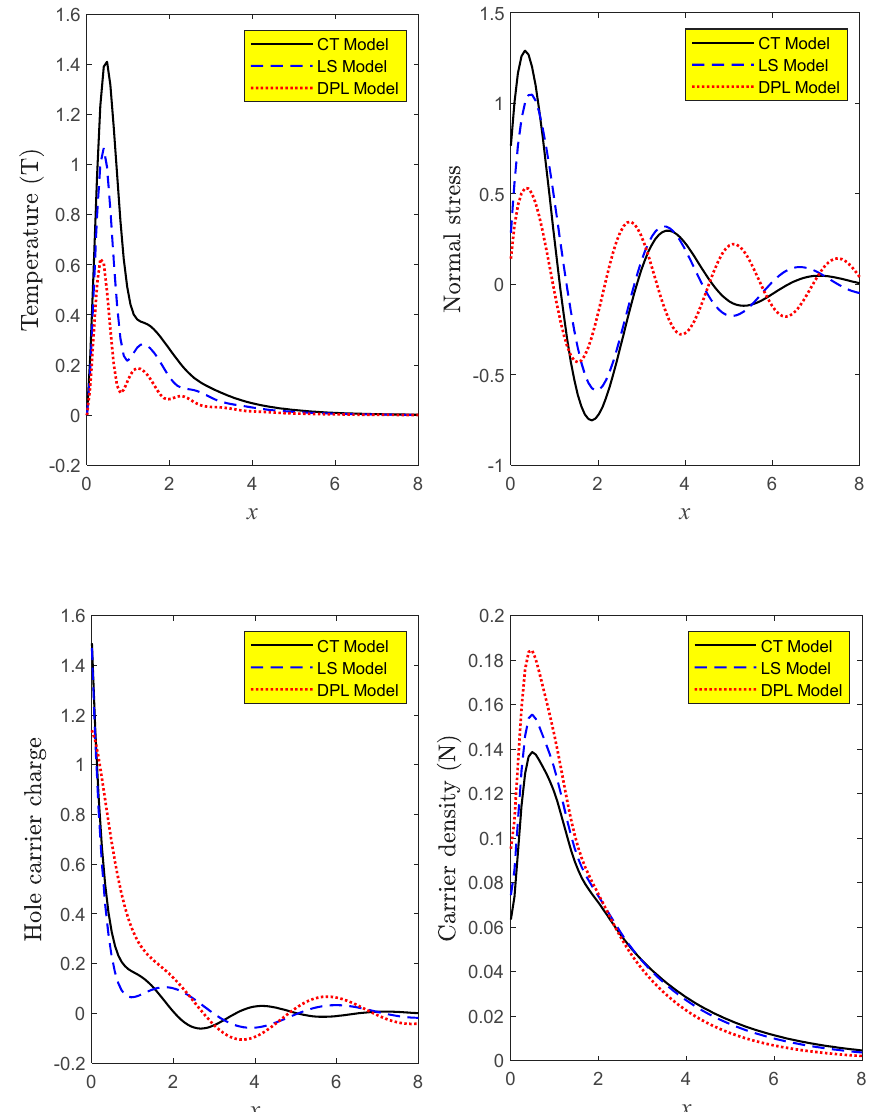
Figure 1. The key physical distributions’ variation in relation to distance under the influence of Hall current and non-local parameters, as predicted by photo-thermoelasticity models.